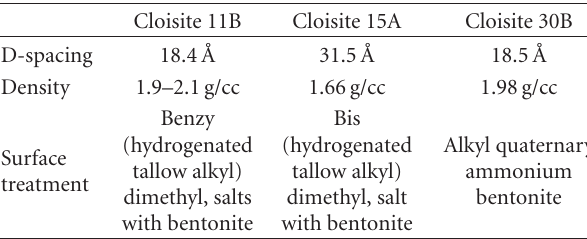
Table 2: Properties of nanoclay